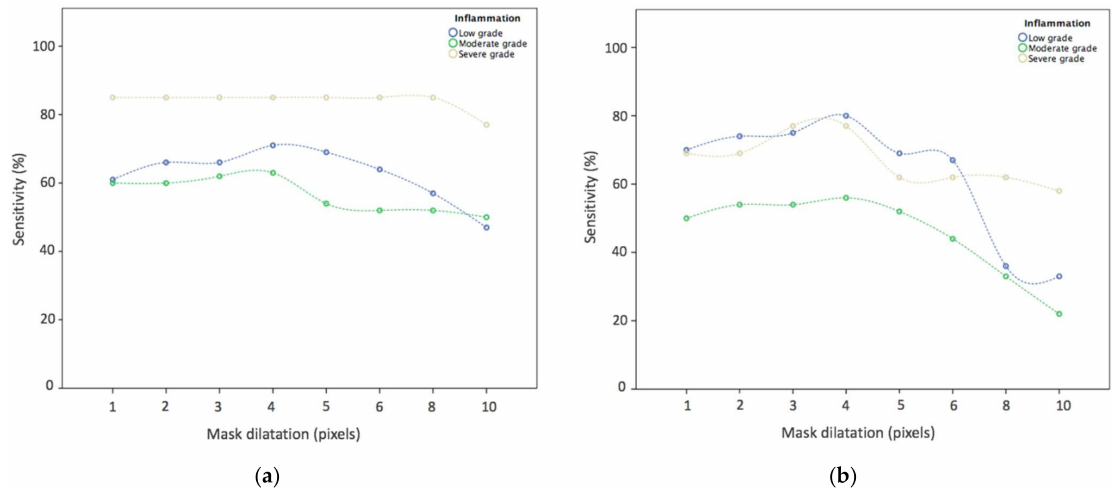
Figure A2. Sensitivity analysis stratified by inflammation grading for ( a ) I-score, and ( b ) C-score, shows that for both parameters a 4-pixel mask dilatation performed the best.